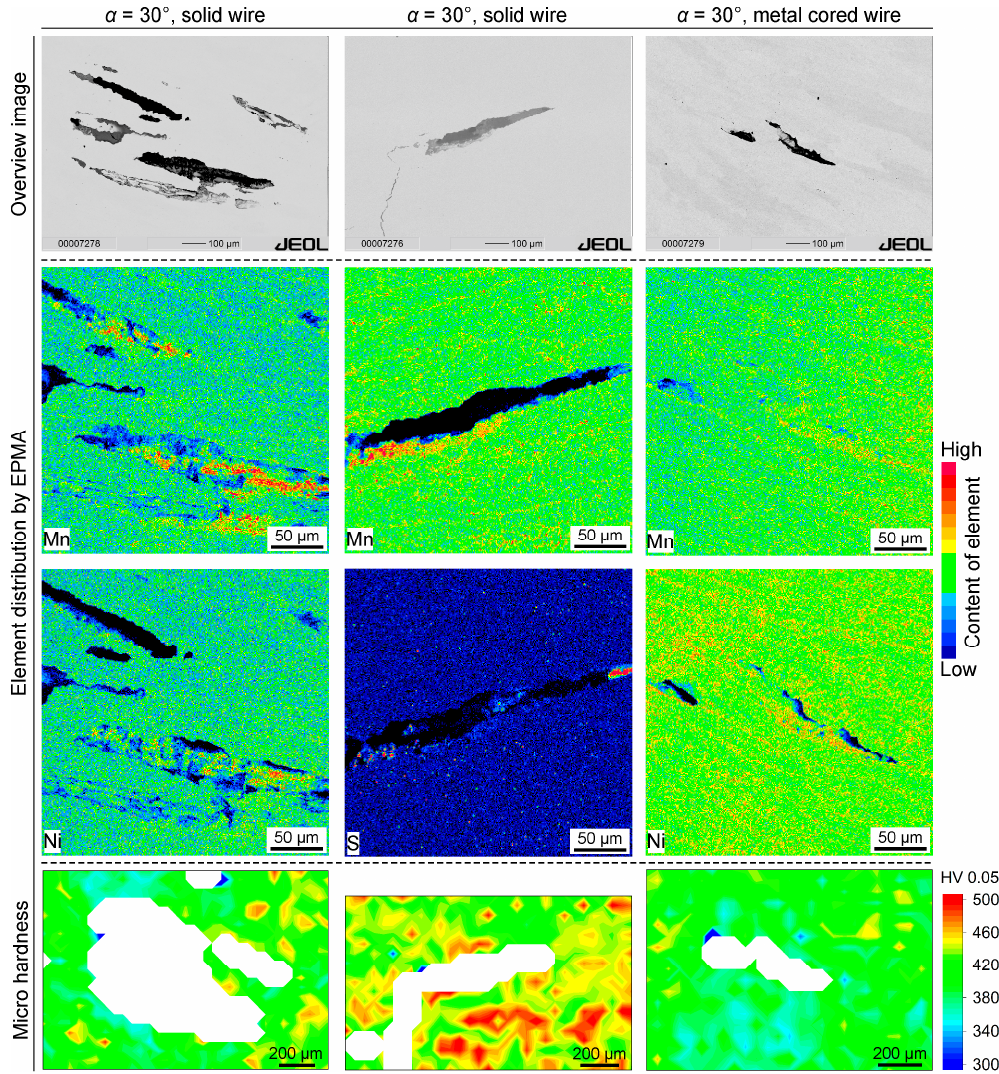
Figure 12. Characterization of cracks in weld metal by electron probe micro analysis (EPMA) and micro hardness meas- urement; indication of qualitatively element concentration by EPMA.